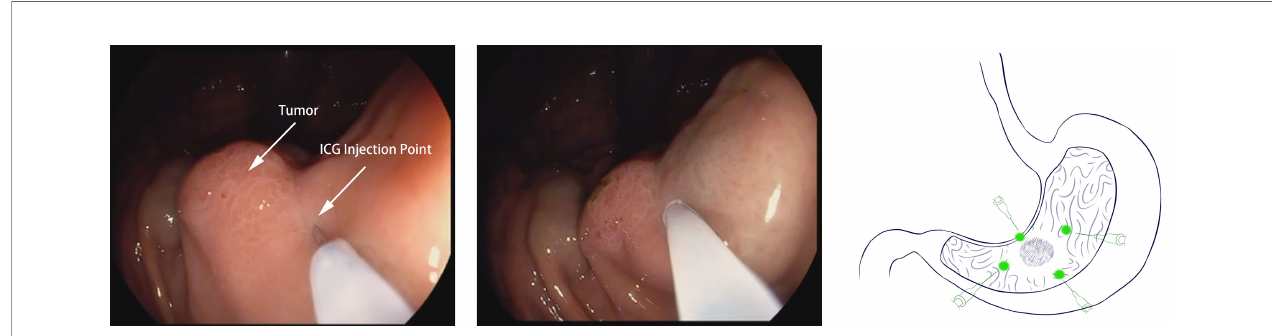
FIGURE 1 | Endoscopic peritumoral ICG injection one day before surgery. A site adjacent to the tumor is selected. Slight swelling of the mucosa without ICG leakage is a sign of